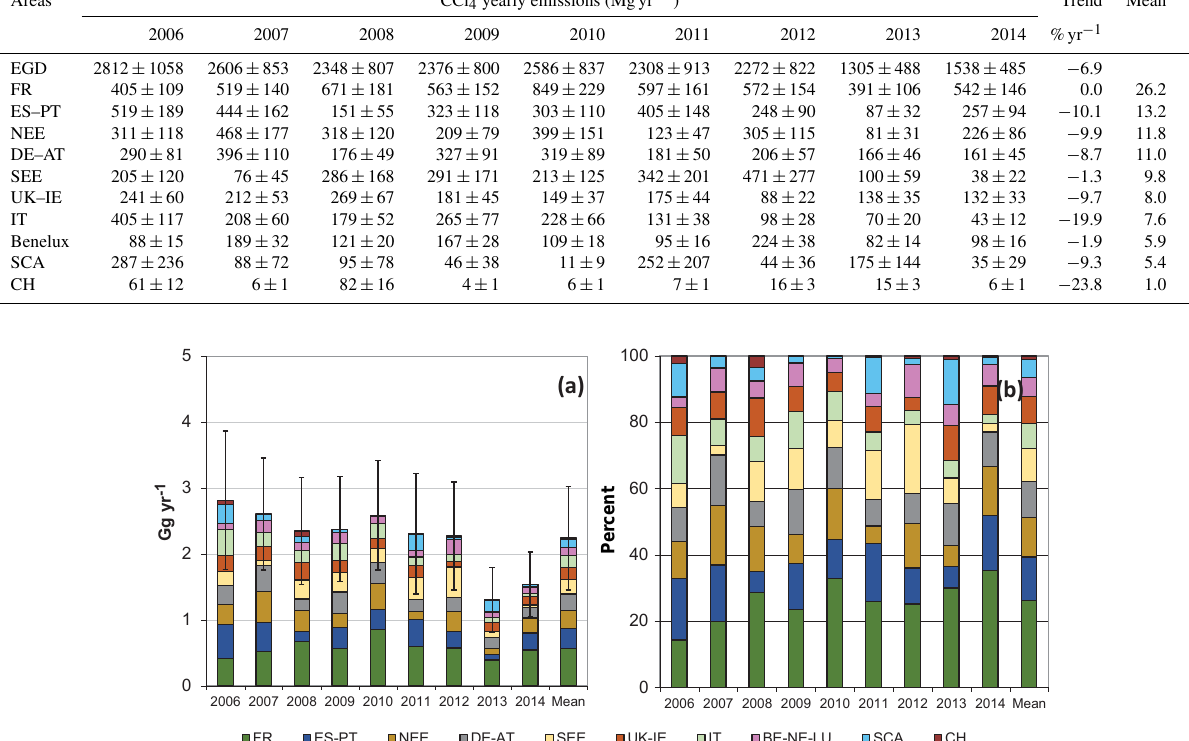
Figure 5. (a) Carbon tetrachloride estimated emissions over the study period given in Ggyr − 1 from the 10 macro areas in the EGD. Error bars represent the uncertainty in emissions as derived from the inversion routine (see Supplement). (b) Yearly percent contributions of the individual macro areas to total EGD